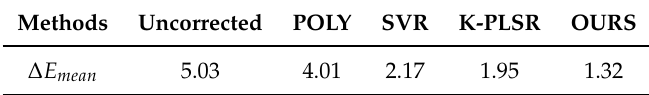
Figure 8. Four color correction methods applied on facial and tongue images and their corrected results, upper: deceive 01, bottom device 02. From left to right, they are uncorrected and the results of the POLY, SVR, K-PLSR, and Ours. Table 6. Comparison results of the mean color differences between two devices.